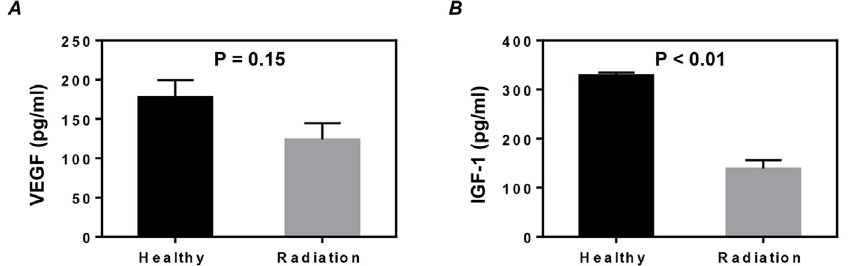
Fig 5. Growth factor production of cardiac stem cells (CSCs). The supernatants of twice-passaged CSCs were collected to measure the concentration of vascular endothelial growth factor (VEGF) (A) and insulin-like growth factor-1 (IGF-1) (B) by ELISA. Values shown are the mean ± SEM from 3 independent experiments.